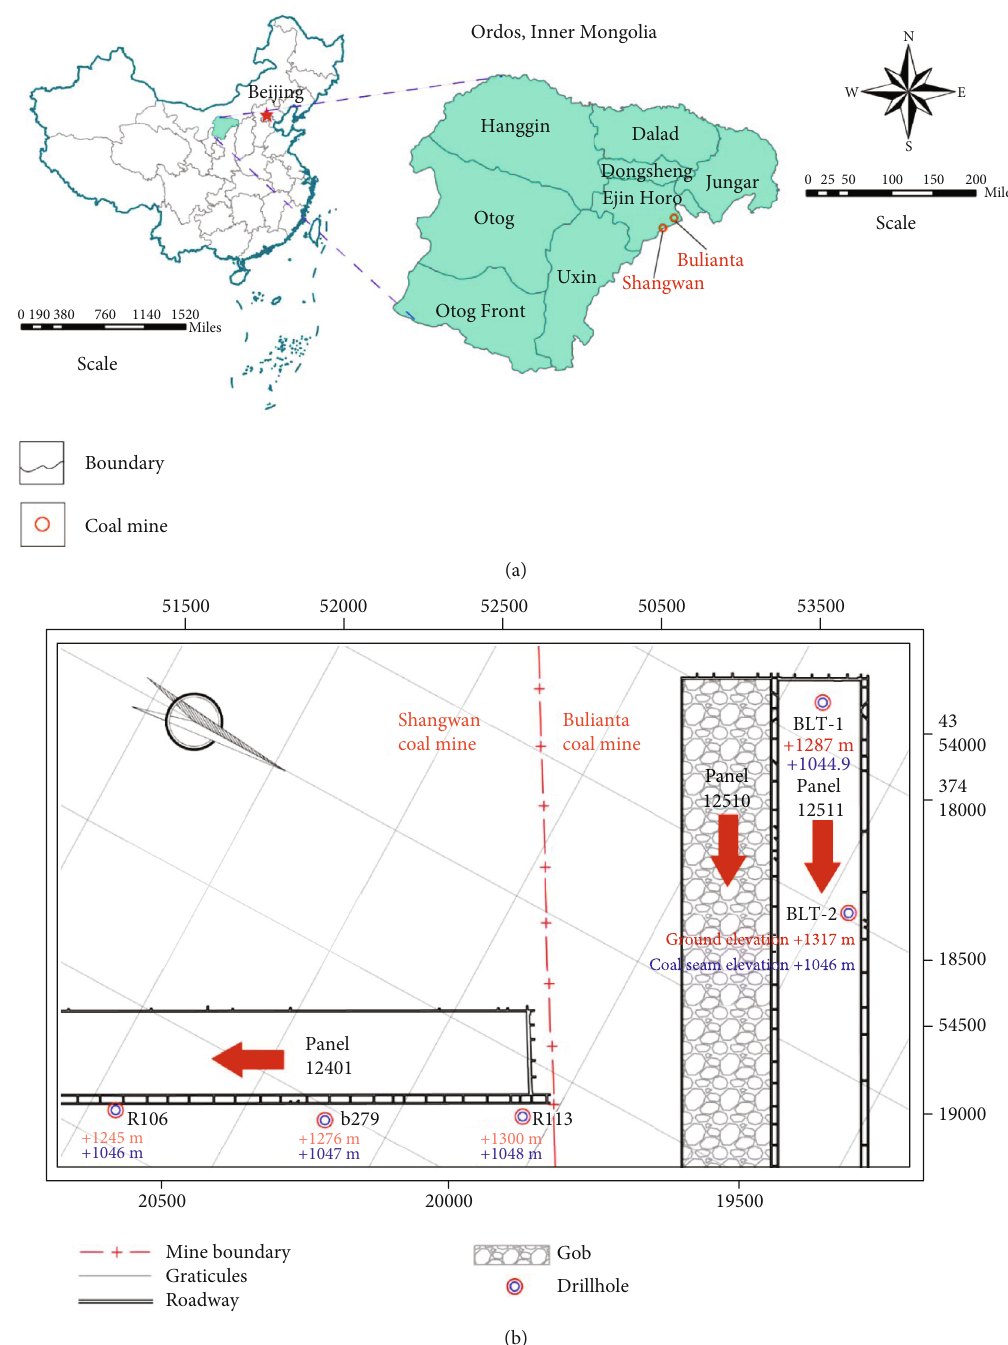
Figure 2: Location of the coal mines (a) and (b) layout of panel 12401 and panel